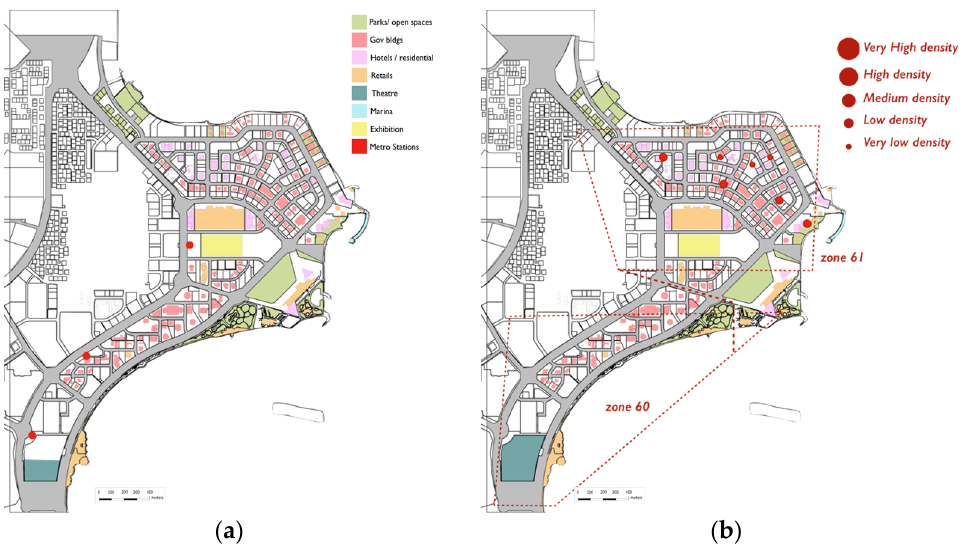
Figure 5. ( a ) West Bay Doha land uses; ( b ) West Bay Doha density.